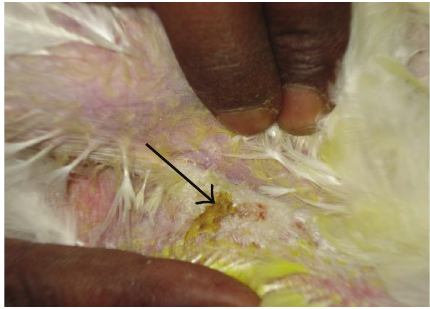
Figure 6: DTH reaction of skin (T-2 toxin plus SBT 400 ppm): mild increase in skin thickness and scab formation compare to toxin fed bird.